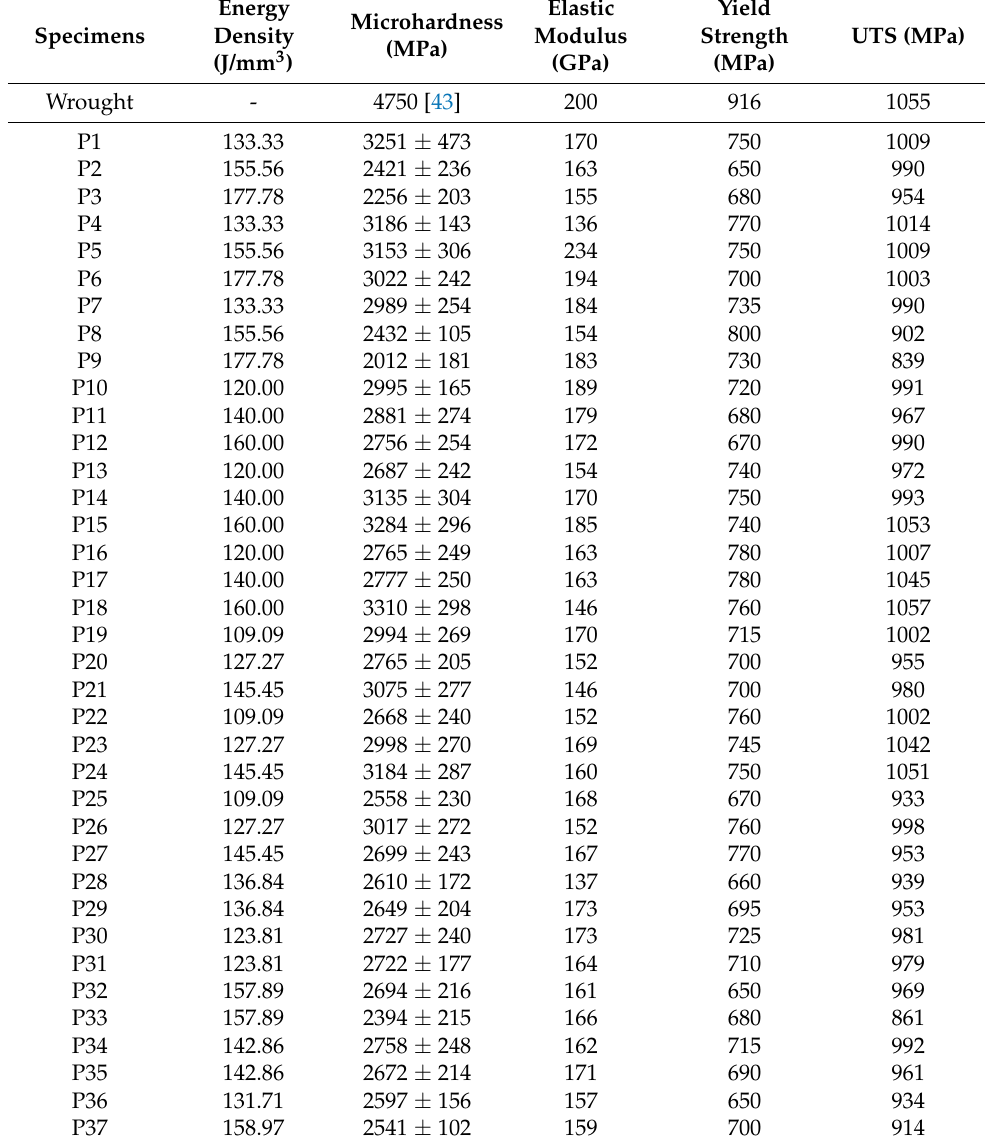
Table 3. Mechanical properties for wrought Inconel 718 samples [23,43] and the examined specimens.